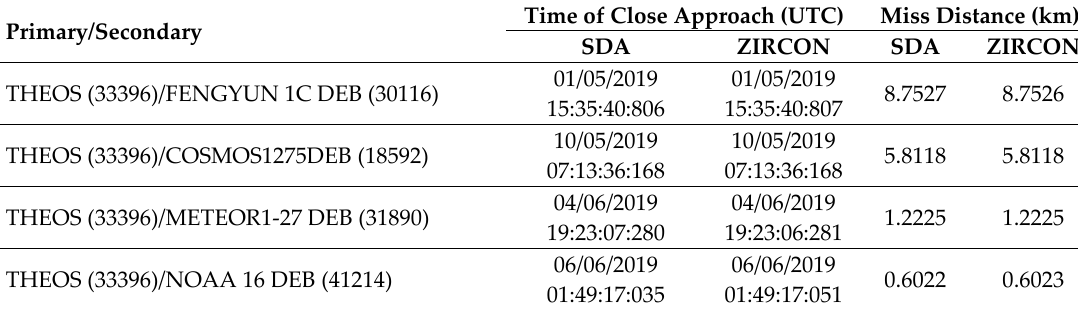
Table 1. Comparison analyzed results between SDA and